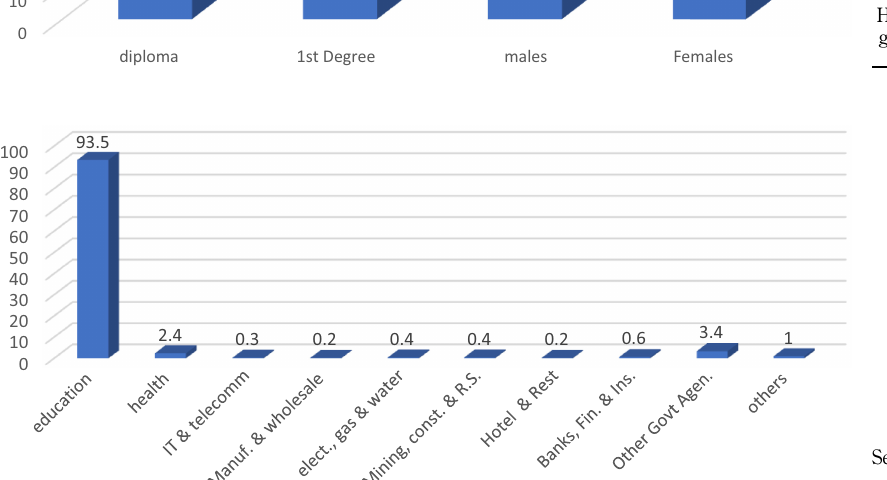
Figure 3. Highest education and